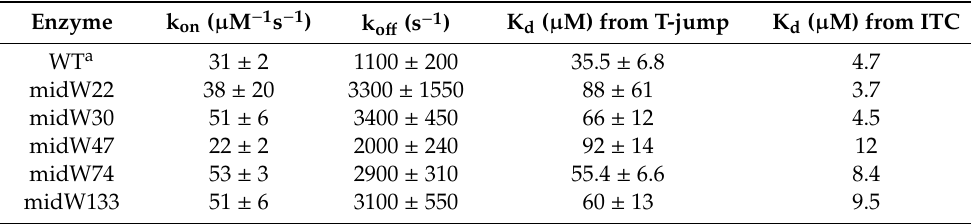
Table 3. The k on , k o ff , and K d for the midW mutants determined by T-jump transient data analysis compared to the K d determined by isothermal titration calorimetry